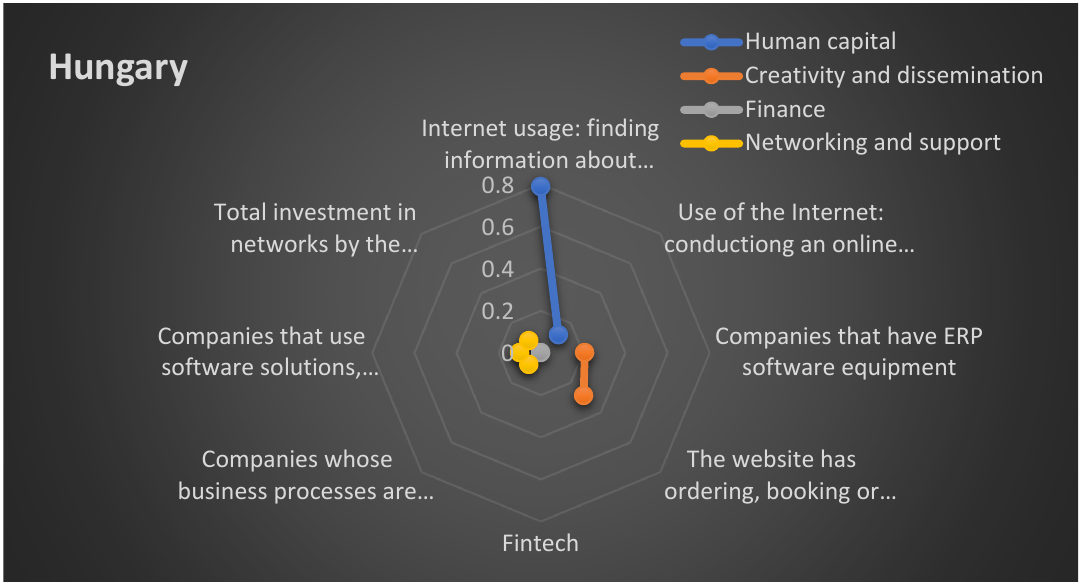
Figure 5. Values of the factors of the digital entrepreneurial system of Hungary, in the scale-up phase of the life cycle of the enterprise, in the digital dimension.